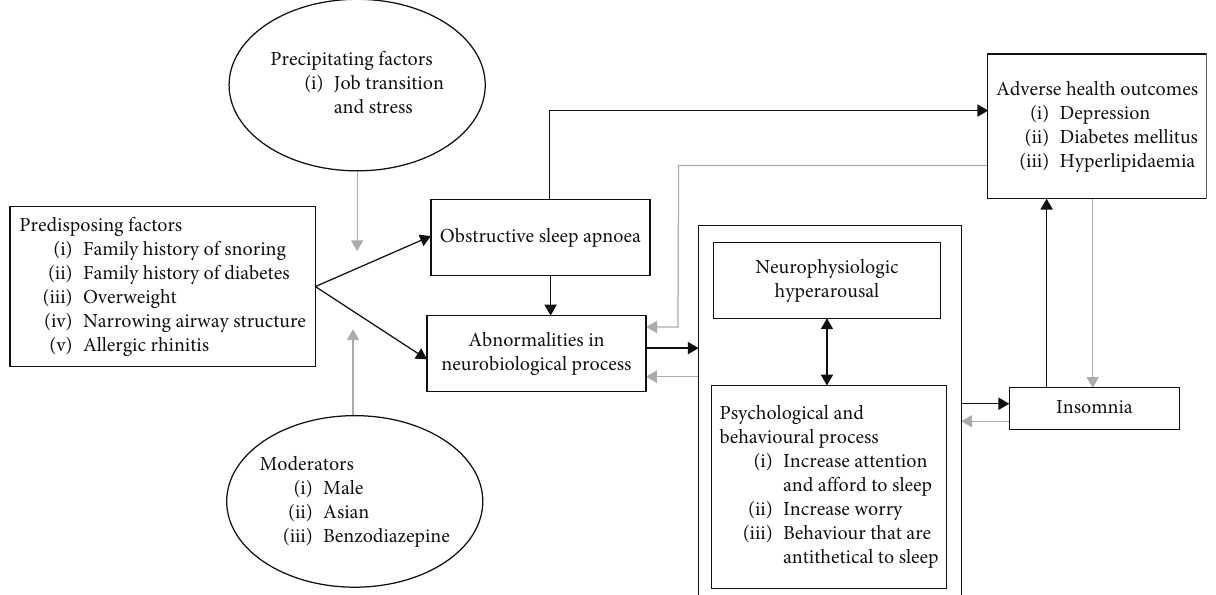
Figure 2: Proposed case conceptualisation (adapted from Levenson et al.